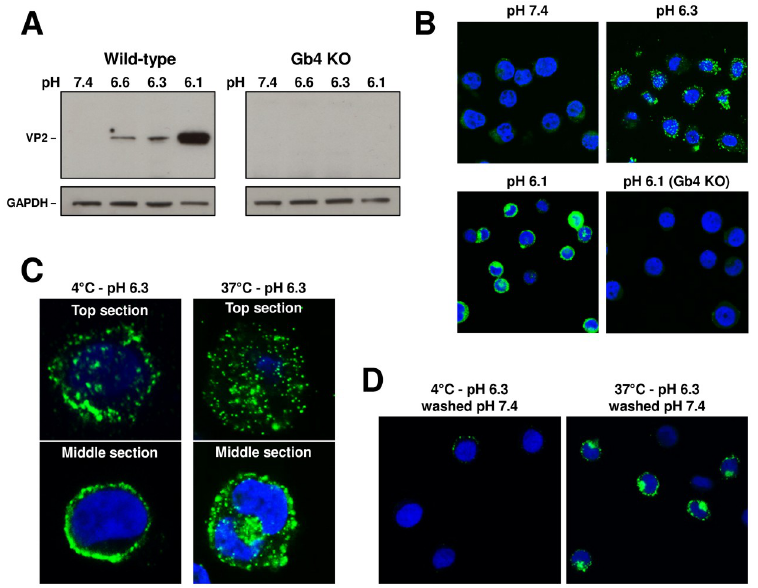
Fig 7. pH-mediated interaction of VP2-only particles with Gb4 triggers the uptake process independently of the VP1uR. (A) Detection of VLPs bound to WT and Gb4 KO UT7/Epo cells at different pH values by Western blot using antibody 3113-81C. VLPs (10 10 ) were incubated with cells (3x10 5 ) at the indicated pH values for 1h at 37˚C. GAPDH expression was used as a loading control. (B) Detection of VLPs (860-55D) in UT7/Epo WT and Gb4 KO cells under neutral or acidic pH by IF. (C) Gb4-mediated uptake of VLPs. Top and middle sections of cells incubated with VLPs at 4˚C or 37˚C for 1h at pH 6.3. (D) Gb4-mediated uptake of VLPs. Cells were incubated with VLPs at 4˚C or 37˚C for 1h at pH 6.3. Non-internalized virus was removed by a washing step at neutral pH. Internalized particles were detected by IF with antibody 860-55D against